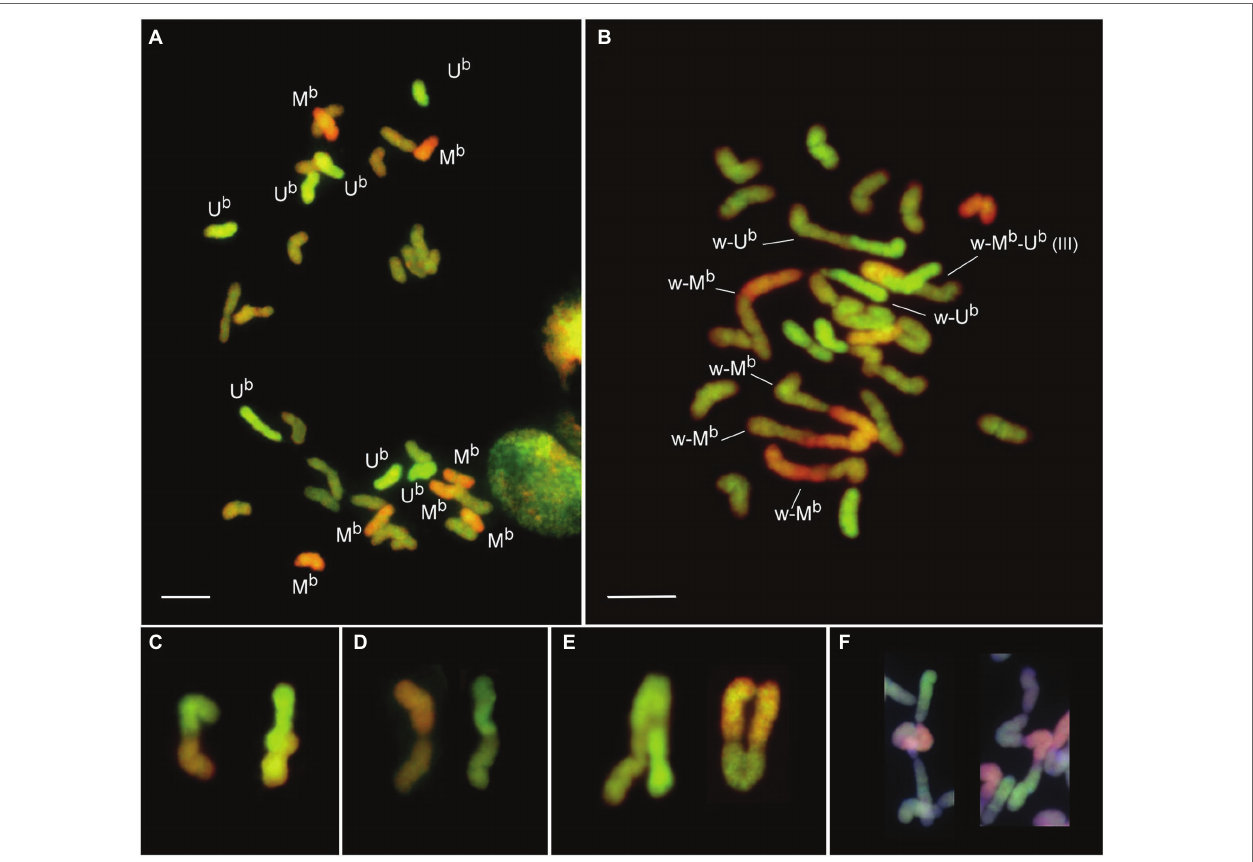
FIGURE 5 | Genomic in situ hybridization of PMCs at MI of bread wheat × Aegilops biuncialis hybrids (2 n = 5 x = 35, ABDU b M b ) in the presence (Mv9kr1) or absence (Mv9kr1 ph1b _K) of the Ph1 locus. (A) MI cell of an Mv9kr1 × Ae. biuncialis MvGB1733 hybrid with functional Ph1 showing the whole chromosome complement, as seven M b (red), seven U b (green), and 21 unlabeled wheat (brown) univalents. (B) MI cell of an Mv9kr1 ph1b _K × Ae. biuncialis MvGB1733 hybrid with seven rod bivalents; four of them involves wheat and M b chromosomes (w-M b ), three involves wheat and U b chromosomes (w-U b ) and one involves wheat chromosomes. A trivalent involving wheat, M b and U b chromosomes was also labeled (III). (C–F) Selected meiotic pairing configurations: U b -M b rod bivalents (C) , wheat-U b and wheat- M b rod bivalents (D) , trivalents involving wheat and U b or M b chromosomes (E) , multivalents involving U b , M b , and wheat chromosomes (F) (in this figure, chromosomes were counterstained with DAPI “blue”). Scale bar 10 μ